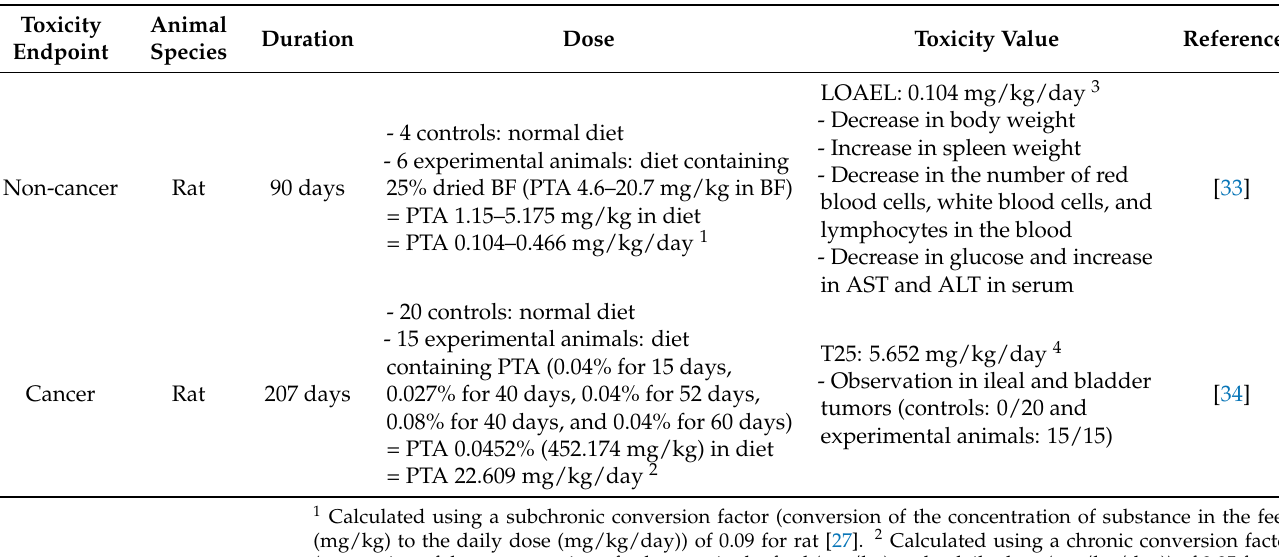
Table 4. Determination of non-cancer and cancer toxicity values for